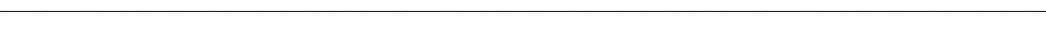
Fig. 1. Stratigraphy, carbon isotope chemostratigraphy and a core log of the Tartu-453 drillcore, southern Estonia. Stratigraphy is after Pıldvere (1998). Abbreviations: N, Nabala RS; R, Rakvere RS; V, Vormsi RS; VOLK., Volkhov RS; F., Fj(cid:228)cka Fm.; Kır., Kırgekallas Fm.; M., Mıntu Fm.; S, Saldus Fm.; Seg., Segerstad Fm.; S., Stirnas Fm.; Tatr., Tatruse Fm.; P., Puikule Member (Mb.); Ro., Rozeni Mb.; Ru., Ruja Mb. The inset is a sketch map of southern Baltoscandia (modified from fig. 1 in Bergstr(cid:246)m et al. 2014) with locations of the Tartu-453, R(cid:246)st(cid:229)nga R-1 and Borenshult drill